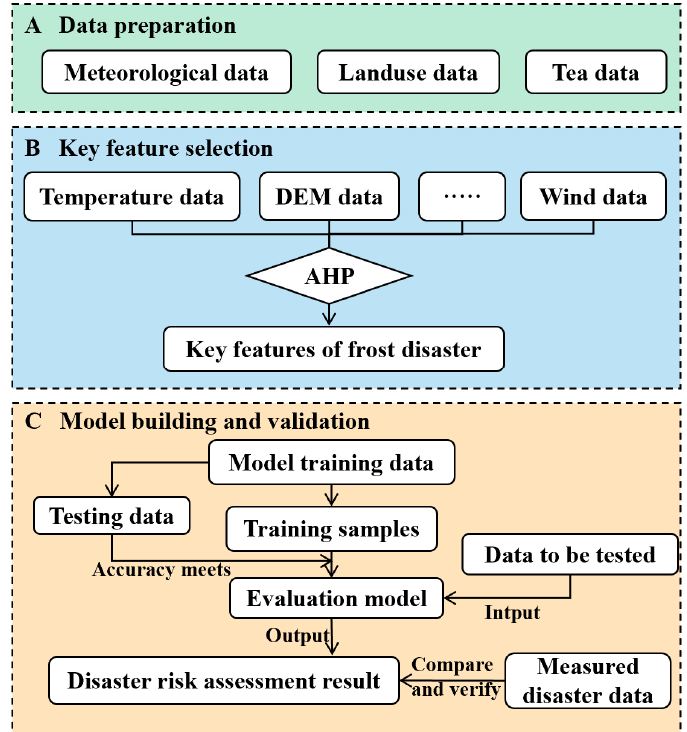
Figure 3. Technical method flow chart.